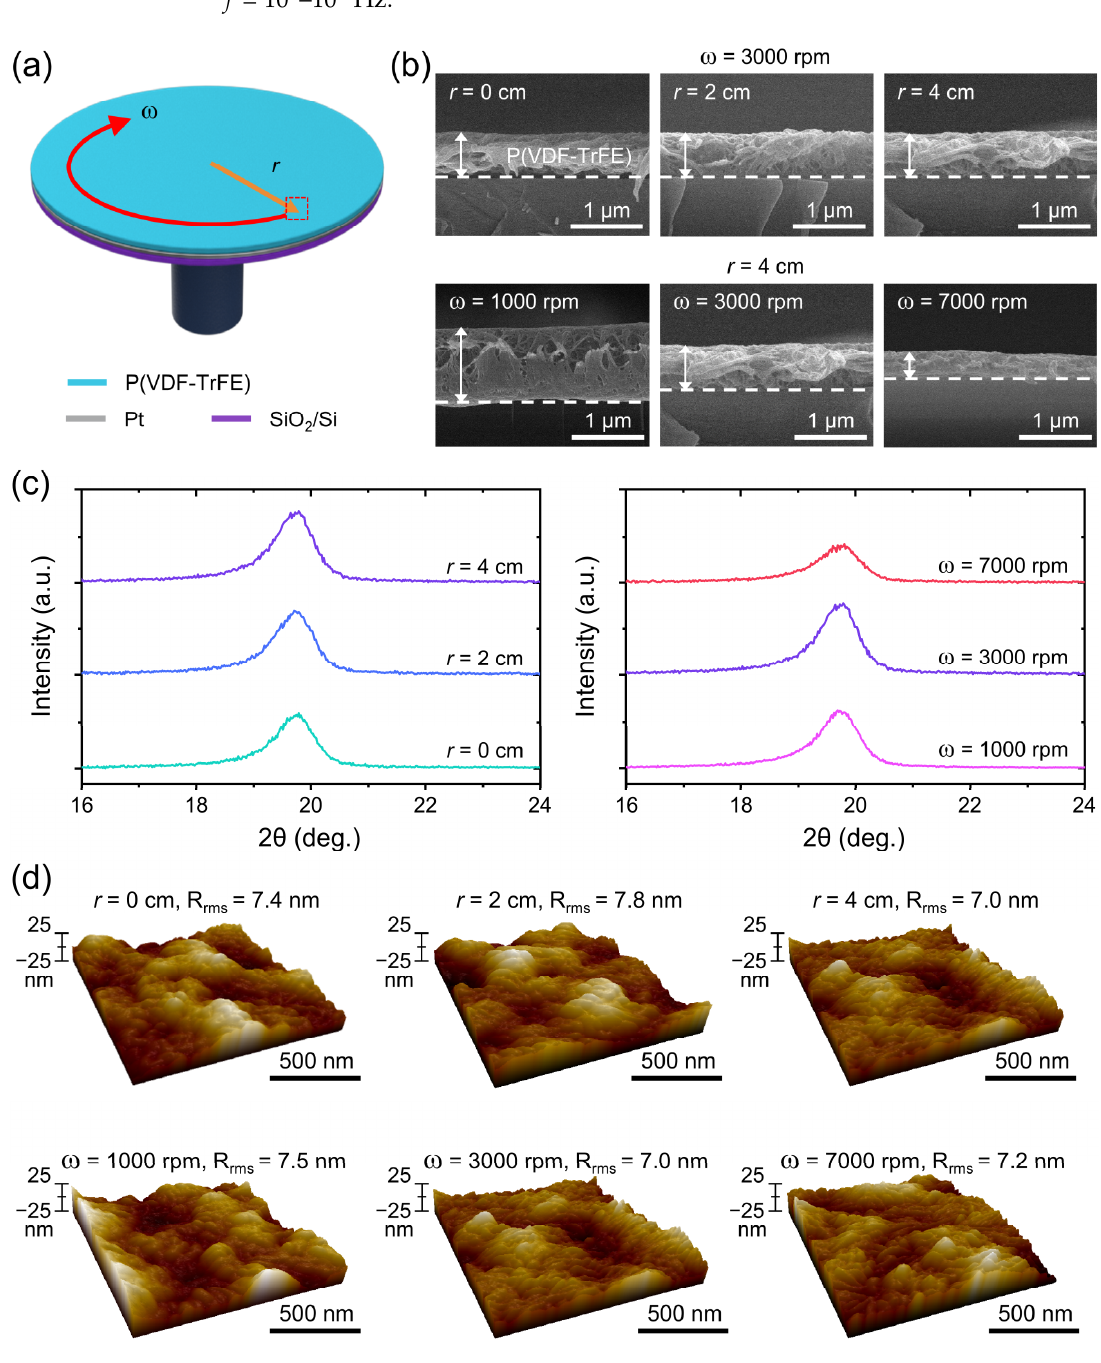
Figure 1. ( a ) Schematic of the spin coating of P(VDF-TrFE) films on a Pt-coated SiO 2 /Si substrate. Film specimens were taken at various distances ( r ) from the center and under different rotational speeds ( ω ). ( b ) Cross-sectional scanning electron microscopy (SEM) images of P(VDF-TrFE) films. The interface between film and substrate is denoted by dashed lines. ( c ) X-ray diffraction patterns and ( d ) atomic force microscopy (AFM) images of spin-coated P(VDF-TrFE) film specimens obtained at various distances from the center and under different rotational speeds. In ( d ), the root-mean-square value of roughness ( R rms ) is shown for each image.